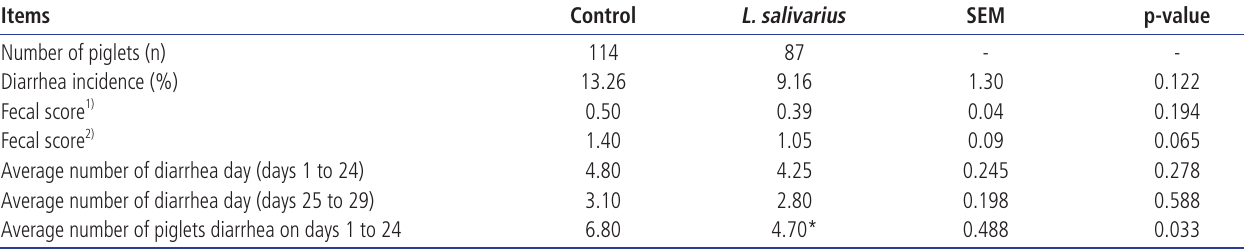
Table 3. Effect of Lactobacillus salivarius on diarrhea incidence of piglets challenged with Escherichia coli F4 Items